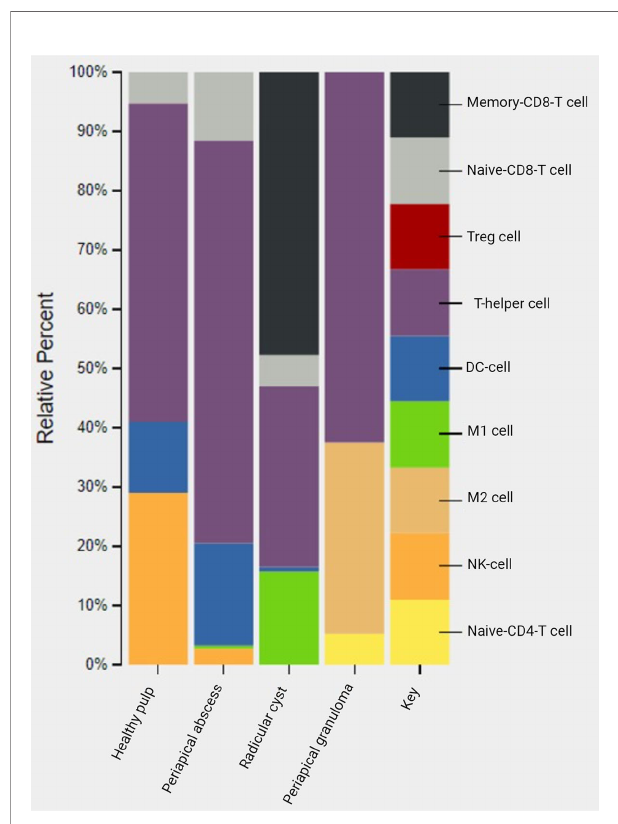
FIGURE 7 | In silico deconvolution of immune cells of periapical lesions compared with healthy control using CIBERSORT. The color key represented the reference list of immune cell genes. Treg, T-regulatory cell; DC cell, dendritic cell; M1, pro-in fl ammatory macrophage; M2, anti-in fl ammatory macrophage; NK, natural killer